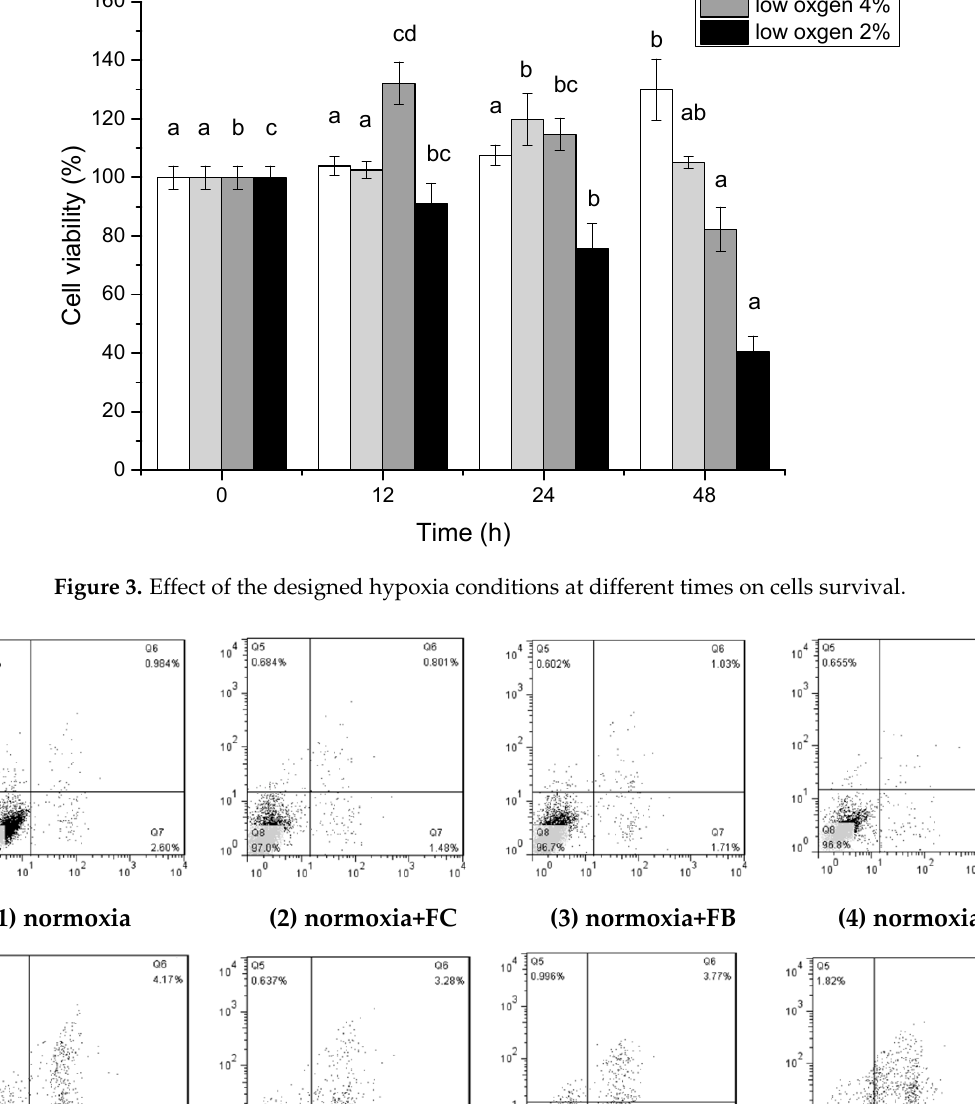
Figure 3. Effect of the designed hypoxia conditions at different times on cells survival.